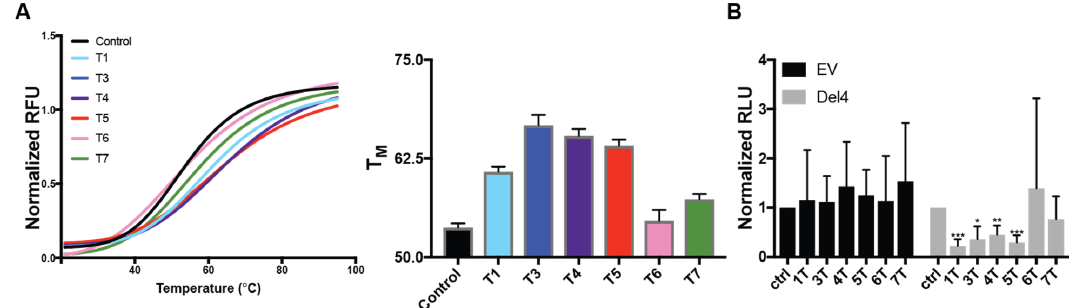
Figure 3. Therapeutic potential of DNAi. Thermal stabilization of MYC G4 formation by the DNAi, as measured by the FRET Melt 2 assay ( A ). Melting curves (left) were analyzed by nonlinear regression methods to determine the T M (right). Equimolar ratios of DNAi 3T, 4T, and 5T demonstrated >10 C increases in thermal stability of MYC G4-forming Pu46, 1T increased thermal stability by 7 ◦ C, while 6T and 7T’s effects were negligible (<4 ◦ C). Experiments were performed in triplicate, each with technical duplicates. ( B ) HEK-293 cells were transiently transfected with a promoterless (EV) or MYC promoter-containing (Del4) luciferase plasmid in the absence and presence of each DNAi at a 1:1 ratio. The effects of the DNAi on promoter activity were examined 48 h later. No DNAi affected the promoterless vector; DNAi 1, 3, 4, and 5T all significantly decreased MYC promoter activity. * p < 0.05, ** p < 0.01, *** p < 0.001; experiments were performed in triplicate.